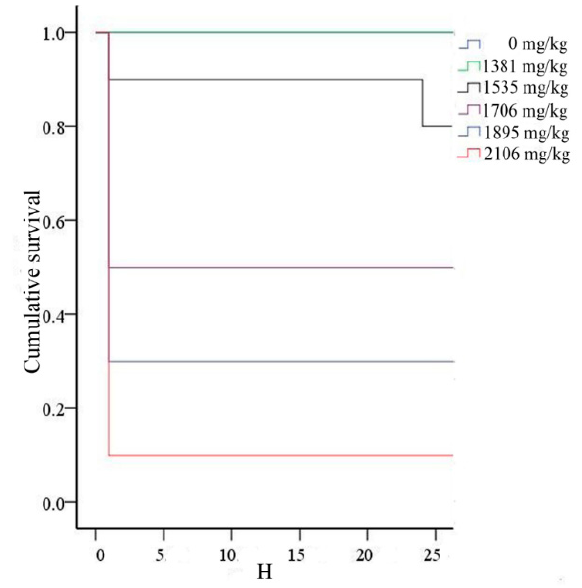
Figure 3. The survival curve for acute toxicity. All of the deaths occurred within 24 h after intravenous administration of SalB-Rg1. Table 1. Effects of SalB-Rg1 on body weight and survival number with a single dose in acute